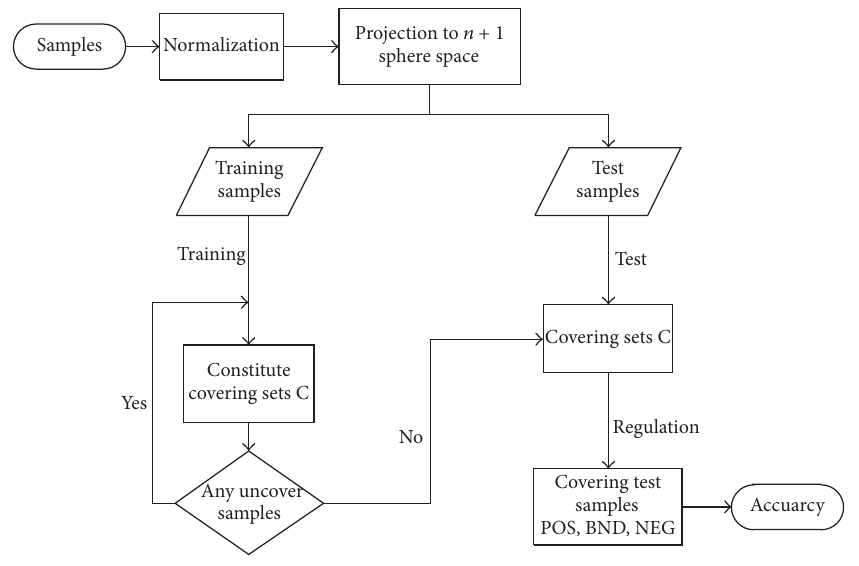
Figure 6: The O CCA